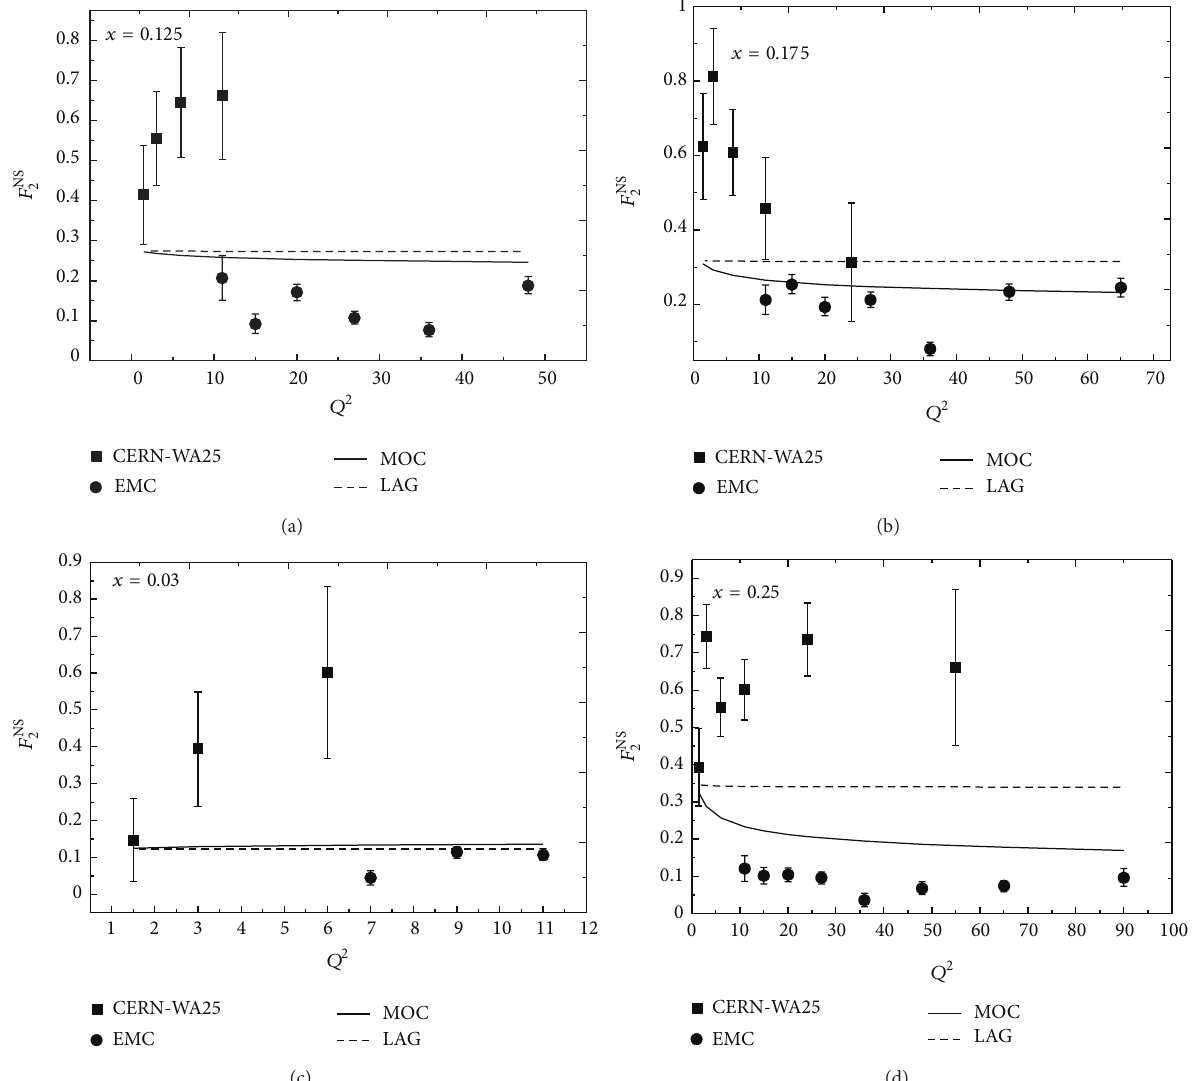
Figure 4: Nonsinglet structure function 𝐹 NS 2 (𝑥,𝑄 2 ) as function of 𝑄 2 at different fixed 𝑥 according to (24) and (53). Data from [19,